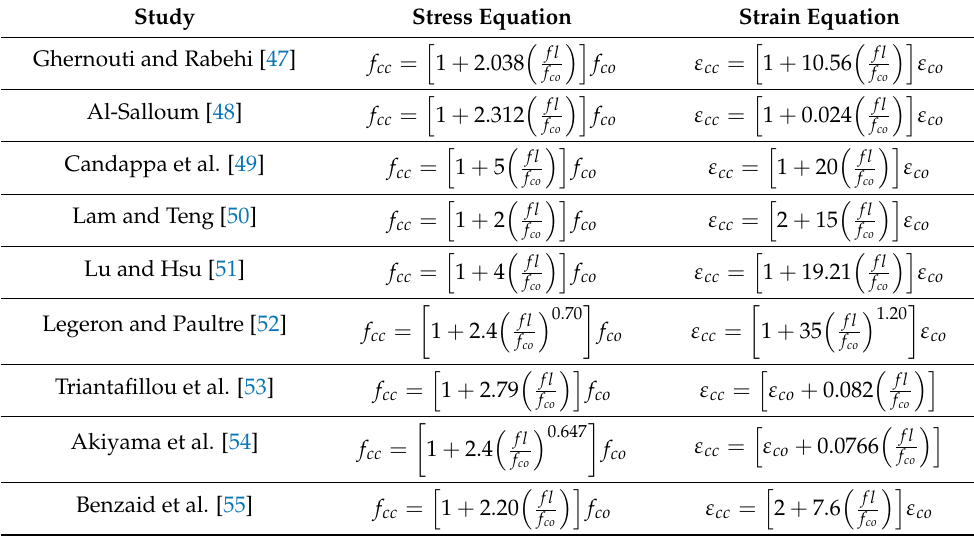
Table 5. Existing models for compressive stress and strain of FRP confined concrete. Study Stress Equation Strain